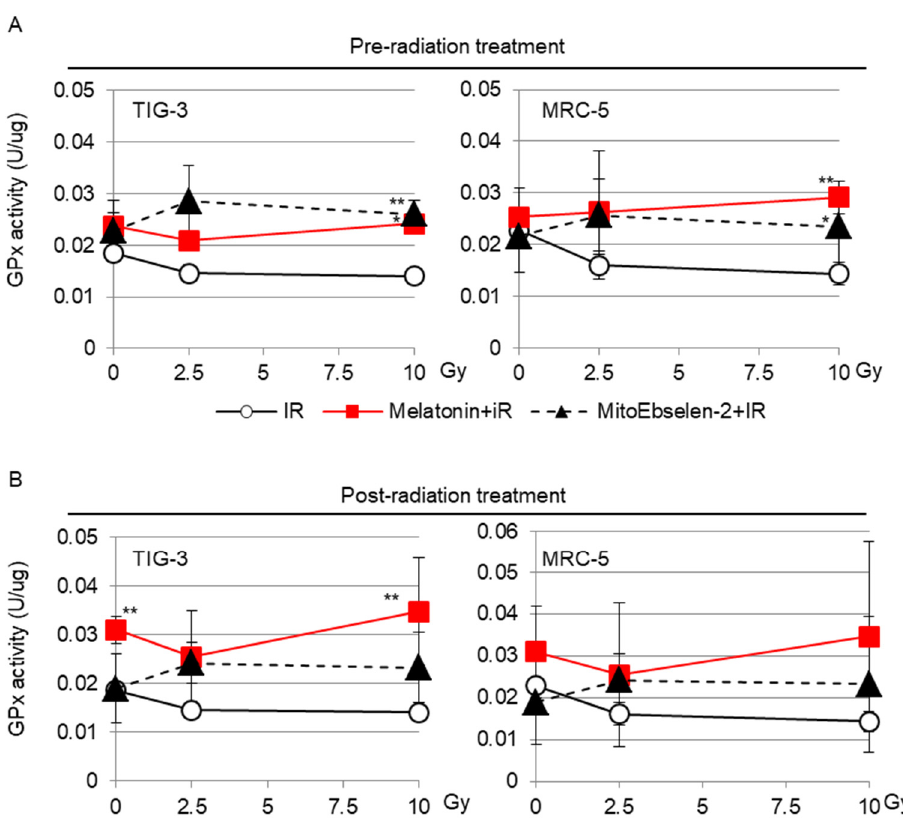
Figure 1. Effect of melatonin or MitoEbselen-2 on the GPx activity: the cells were treated with melatonin or MitoEbselen-2 before (pre-radiation treatment, ( A )) or after (post-radiation treatment, ( B )) IR. The GPx activity at 1 day after irradiation in indicated samples. Asterisk indicates a significant difference in the GPx activity of IR+ melatonin group and IR+ MitoEbselen-2 group compared with that of IR groups at same Gy level.